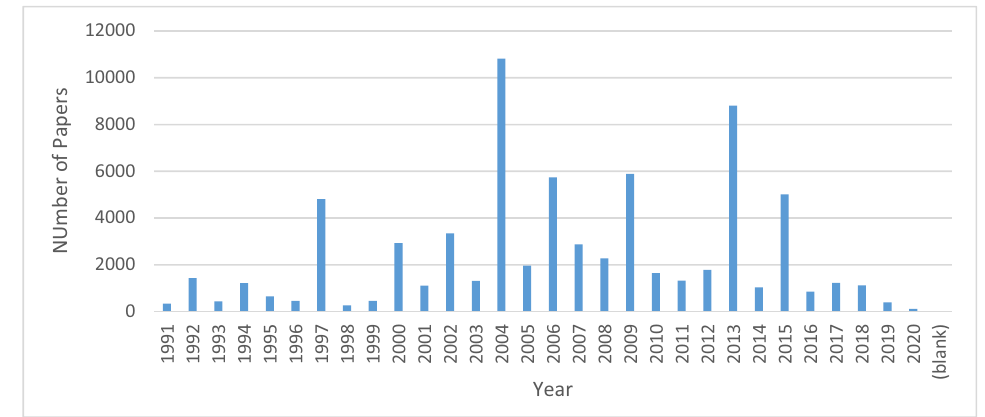
Figure 1: Number of articles published each year.